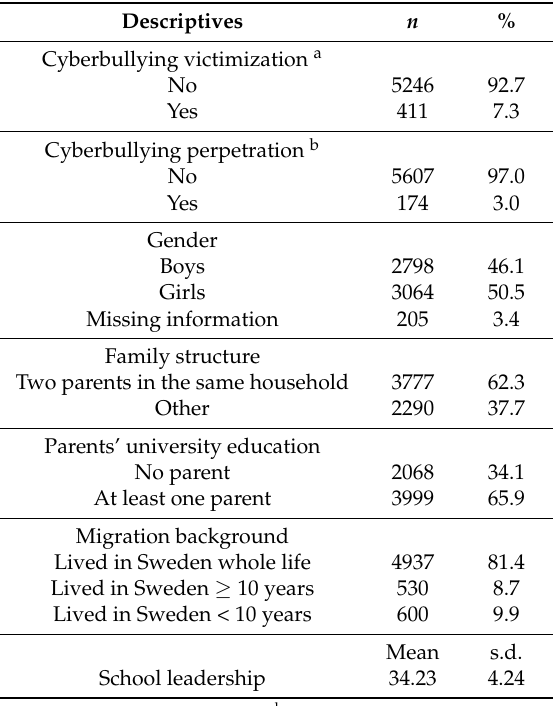
Table 1. Descriptives of variables included in the analyses. n = 6067.